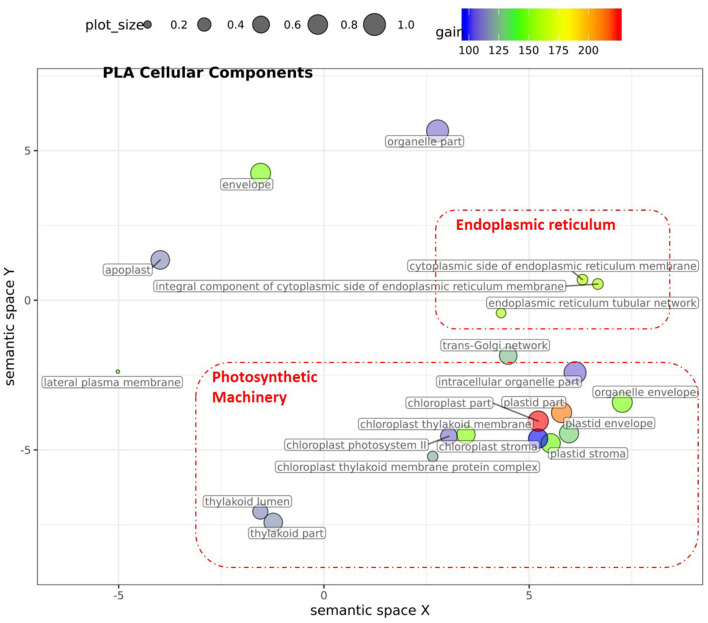
Semantic clustering of GO informed prediction for PLA. Multidimensional scaling (MDS) plot of the representative subset (i.e., terms remaining after the redundancy reduction) of cellular component GO terms informative for PLA. Semantically similar GO terms are clustered based on the “SimRel” semantic similarity measure using Revigo (Supek et al., 2011). Dot size is proportional to the number of genes annotated with the GO term, such that more general GO terms have larger bubbles. The x and y coordinates indicate relative virtual cluster distances in 2 dimensions. The %gain of a particular GO term is indicated by the bubble color.